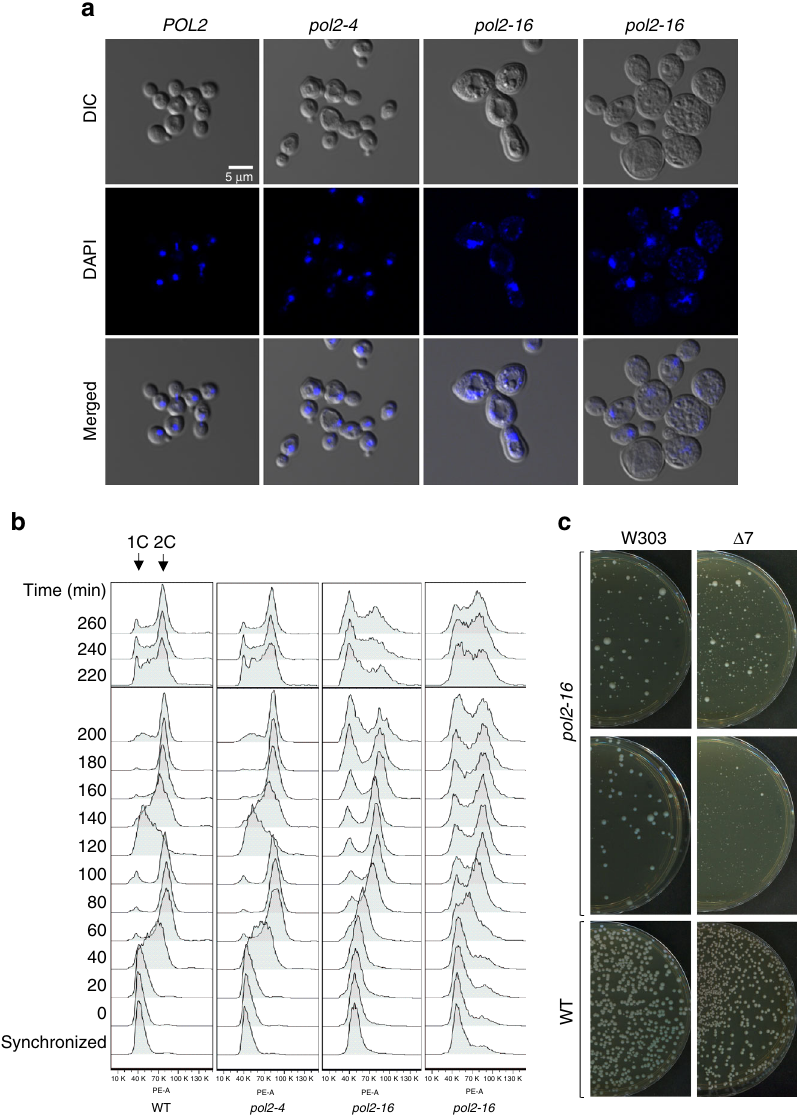
Fig. 2 Phenotypes of wild-type, pol2-4 , and pol2-16 mutants. a Confocal microscope images of DAPI stained, exponentially growing yeast in the synthetic complete media, fi xed with 70% ethanol. The pol2-16 cells are much bigger than wild-type and pol2-4 cells and have aberrantly distributed DNA. b Flowcytometric analysis of cell cycle progression. Yeast cells were α -factor arrested in G1 phase, then released into complete media, sampled every 20 min, fi xed with 70% ethanol, stained with propidium iodide, and then analyzed with fl ow cytometry (Methods). 1C and 2C indicate the DNA contents. c Colony size heterogeneity in the pol2-16 outgrowths. Resuspended pol2-16 and POL2 spore colonies, were plated on solid complete media and incubated at 23 °C for 6 and 4 days,